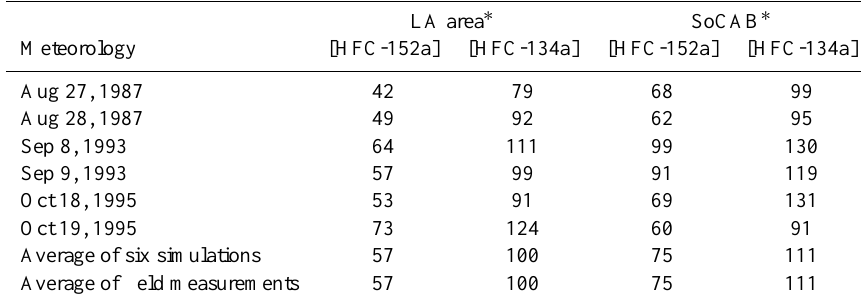
Table 3. Average measured and predicted mixing ratios (in ppt) of HFC-152a and HFC-134a in the LA area and SoCAB (0–1100m in elevation) during